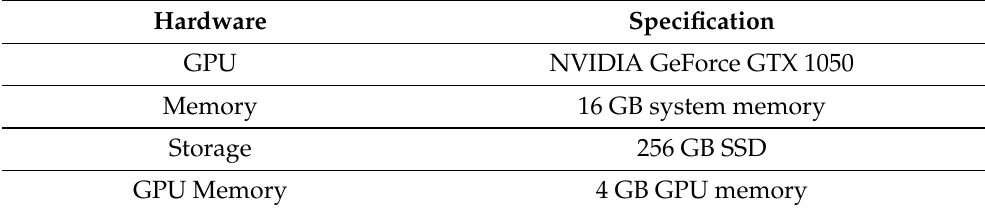
Table 5. Hardware specifications of the computer used for training.